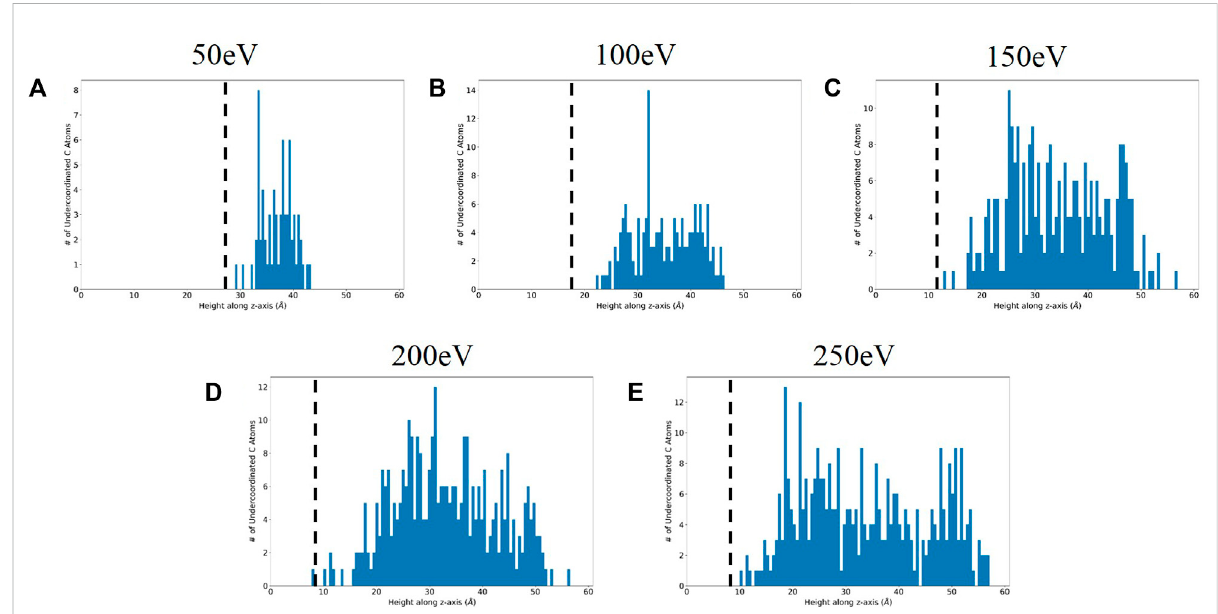
FIGURE 7 Height distribution of undercoordinated carbon atoms for (A) 50 eV, (B) 100 eV, (C) 150 eV, (D) 200 eV, and (E) 250 eV cases with interface threshold from coordination number analysis marked with the dotted black